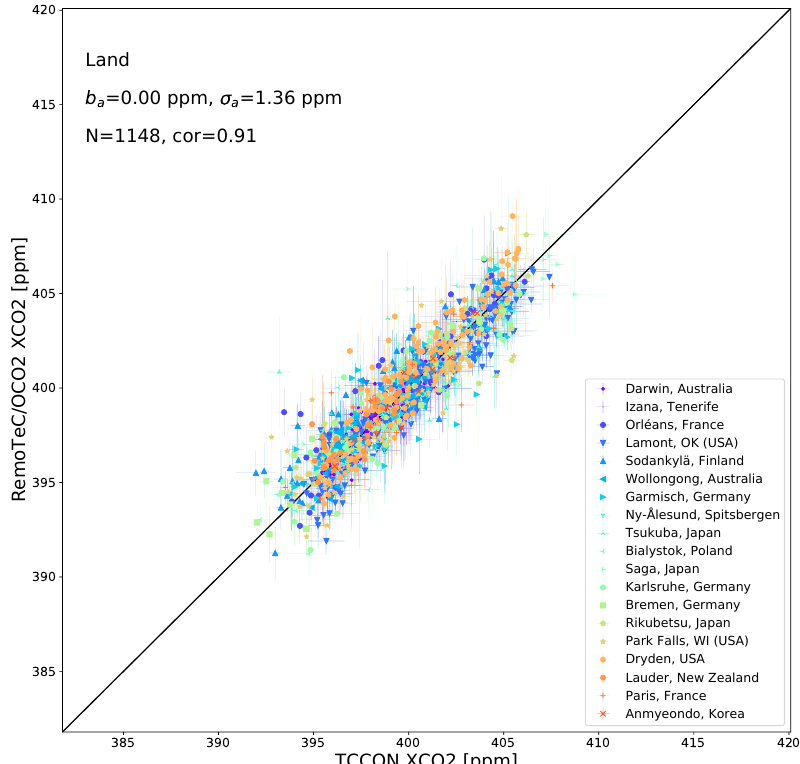
Figure 6. Same as Fig. 5, but for OCO-2 land type measurements obtained under nadir and glint